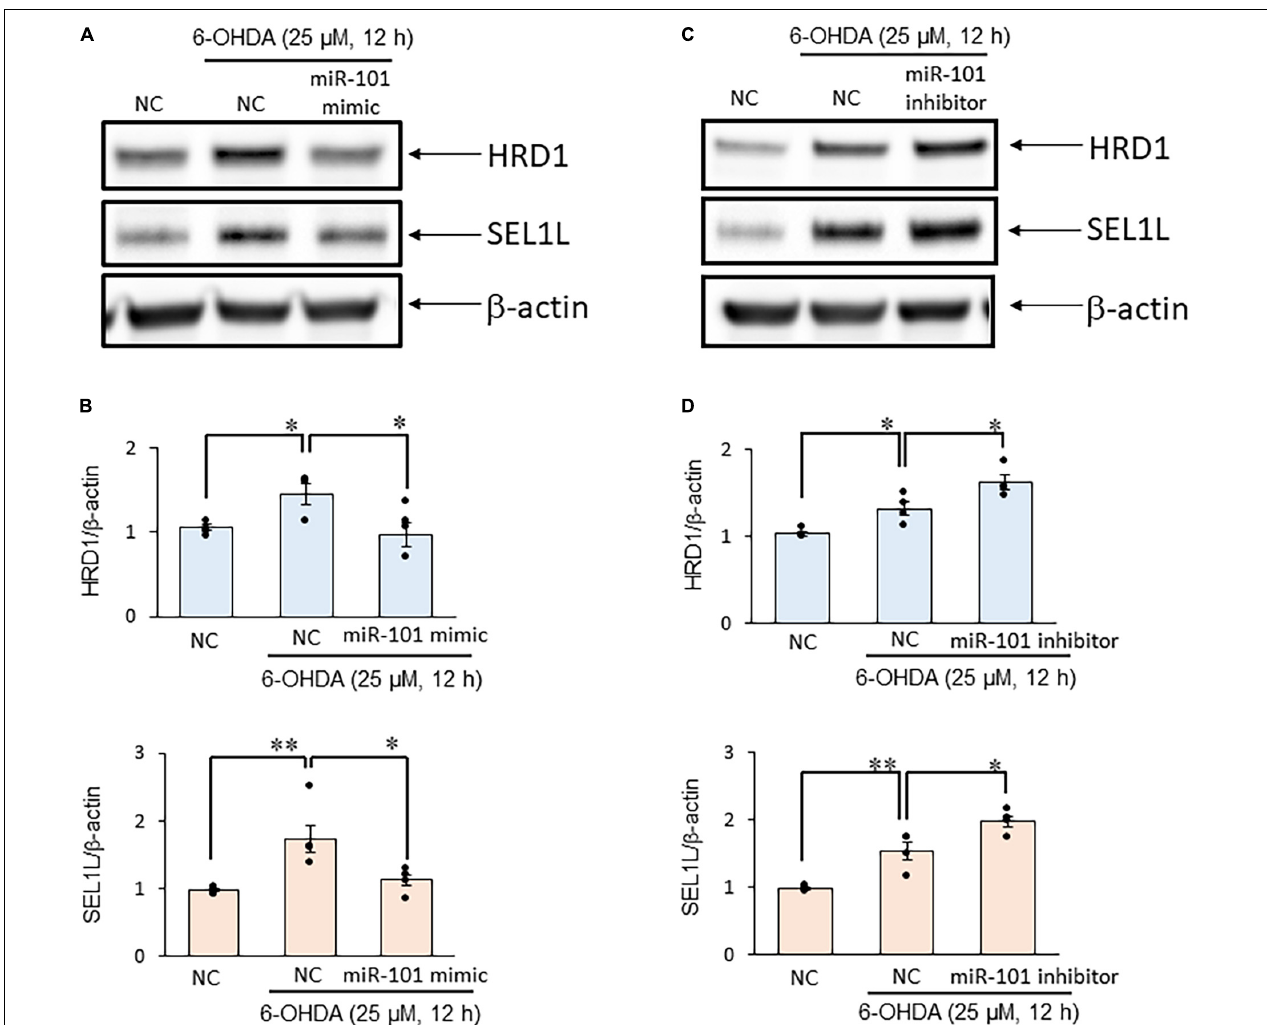
FIGURE 3 | MiR-101 affects suppressor/enhancer lin-12-like (SEL1L) protein expression in a cellular model of Parkinson’s disease (PD). (A,C) SH-SY5Y cells were transfected with the negative control (NC), miR-101 mimic, or miR-101 inhibitor for 48 h and then stimulated with 25 µ M 6-hydroxydopamine (6-OHDA) for 12 h. Representative western blots of SEL1L, HMG-CoA reductase degradation 1 (HRD1), and β -actin are shown. (B,D) Immunoreactive bands were quantified and expressed as means ± standard errors of the mean of four independent experiments. ∗ p < 0.05 and ∗∗ p < 0.01, one-way analysis of variance with Tukey’s post hoc